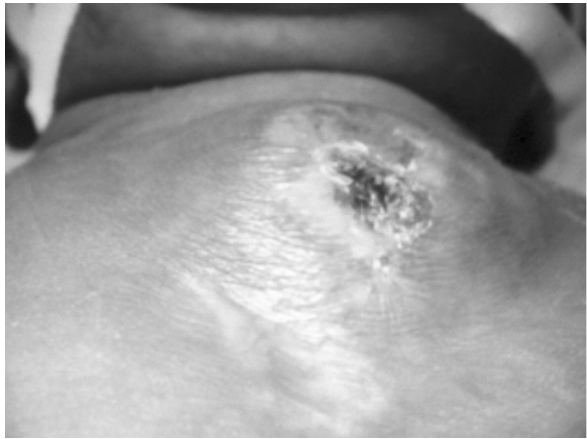
Fig. 1 - Coração na face anterior do tórax, recoberto apenas pelo pericárdio, já com sinais de necrose